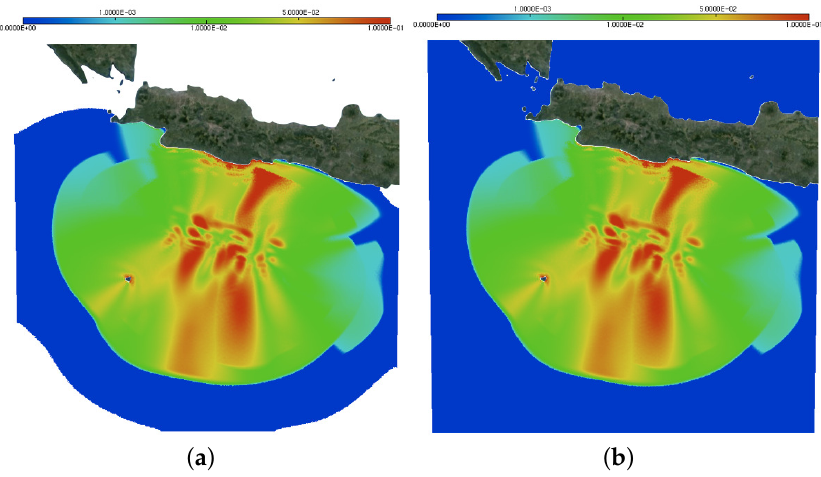
Figure 24. Active generation: comparison between the maximum of the solution at t = 1750 s, with the domain adaptivity method ( a ) and with the full one ( b